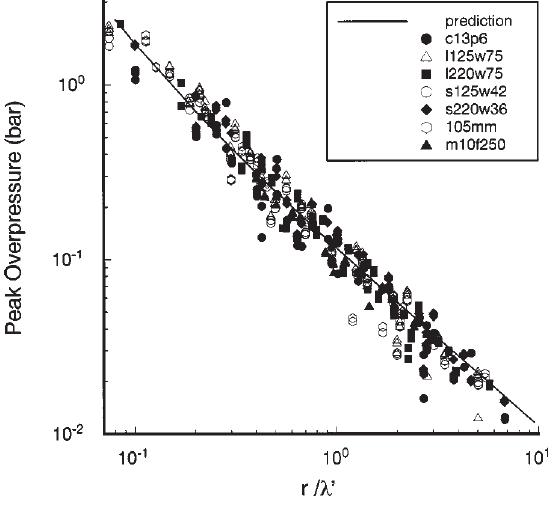
Fig. 4. Peak overpressure versus r/λ (cid:48) with least squares